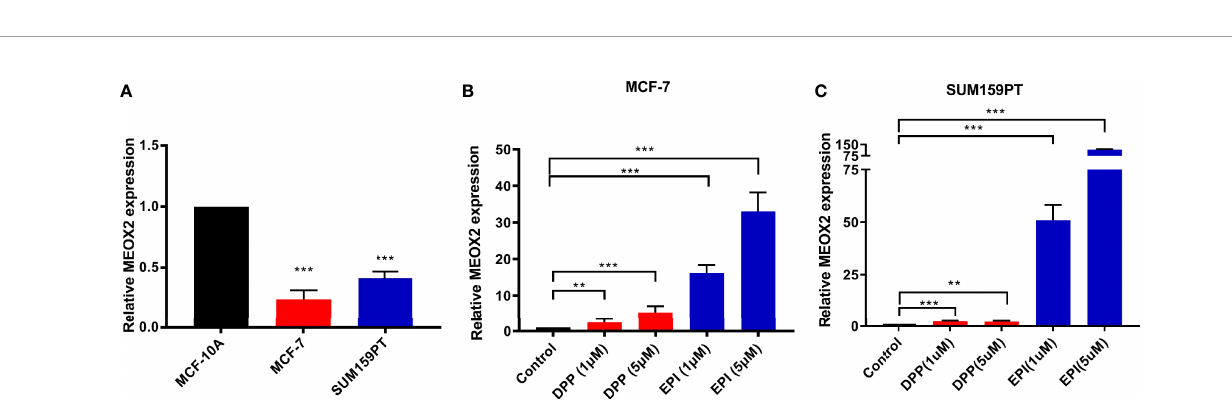
cancer patients ( Figure 6A ). The length of survival in the upper quartile of the high expression cohort was 121.2 months,